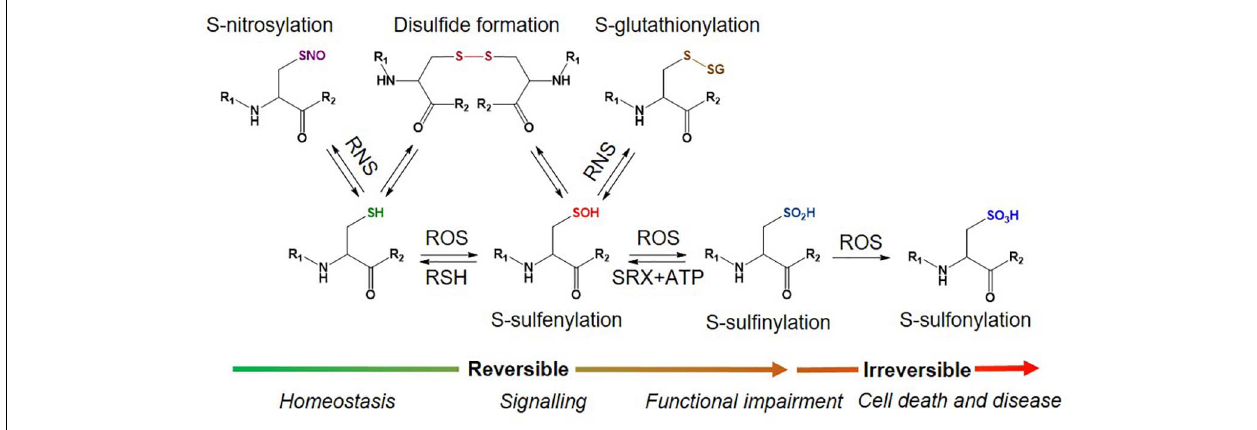
FIGURE 1 | Different types of Oxy-Cys PTMs occurring in